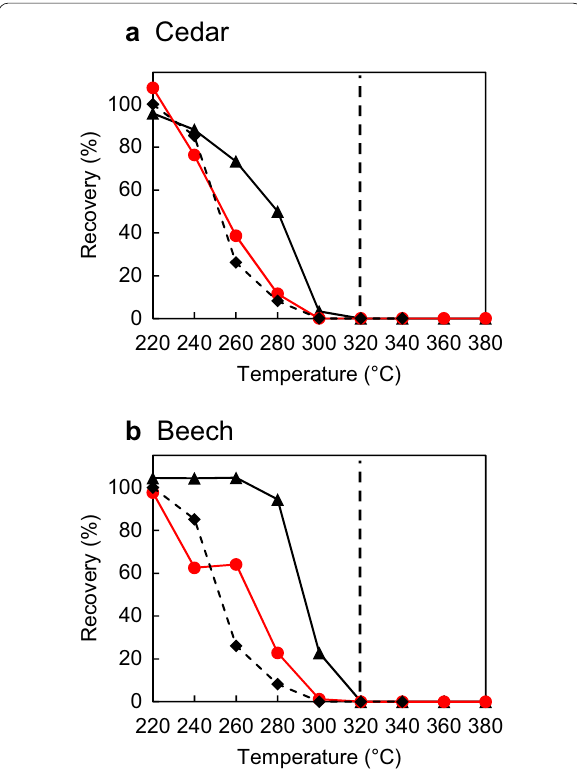
Fig. 5 Comparison of the recovery rates of 4- O -MeGlcA units in pyrolysis of untreated wood ( ▲ ), holocelllulose ( ) and isolated xylan ( ♦ ). Dashed lines at 320 °C are inserted to facilitate comparison